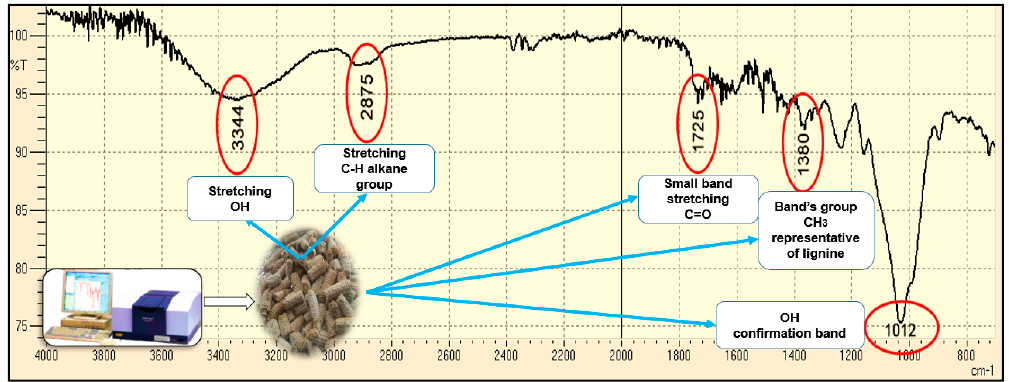
Figure 3. IR spectra of the corncob taken on an IR AFFINITY-1S equipment Shimadzu brand with the ATR technique of Total Attenuated Reflection.